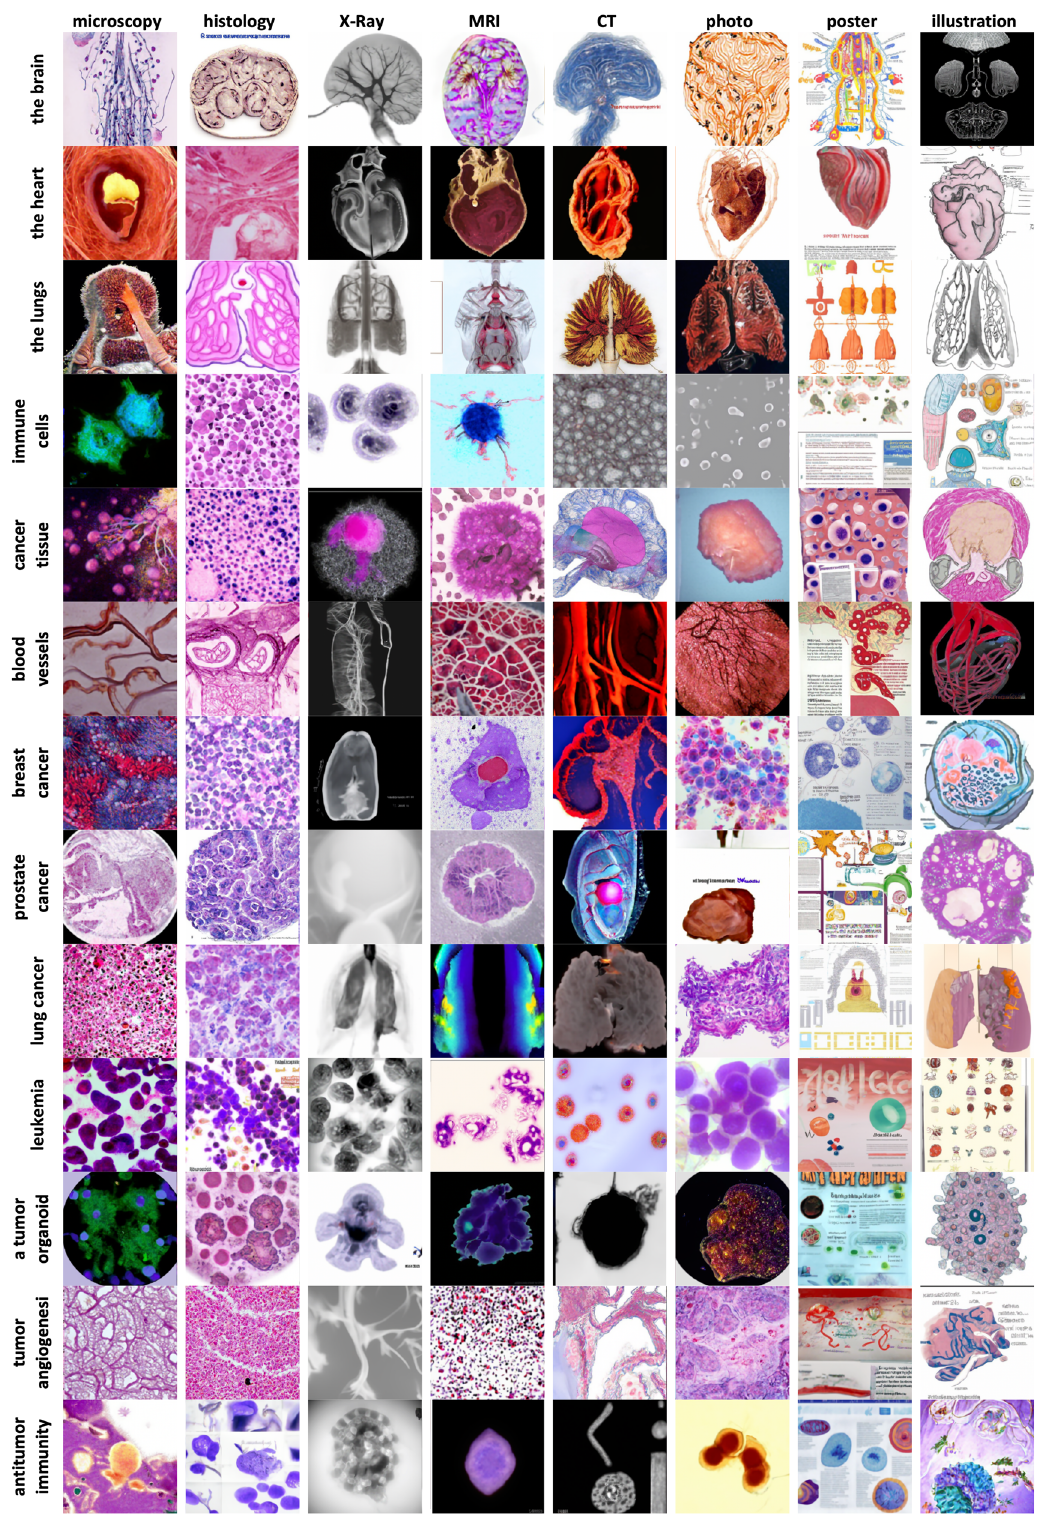
Fig. 1 Example images by target category and modality. All images were generated with a CLIP-conditioned GLIDE. One example was chosen from eight instances per